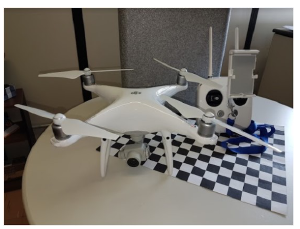
Figure 2. DJI Phantom 4 Advanced